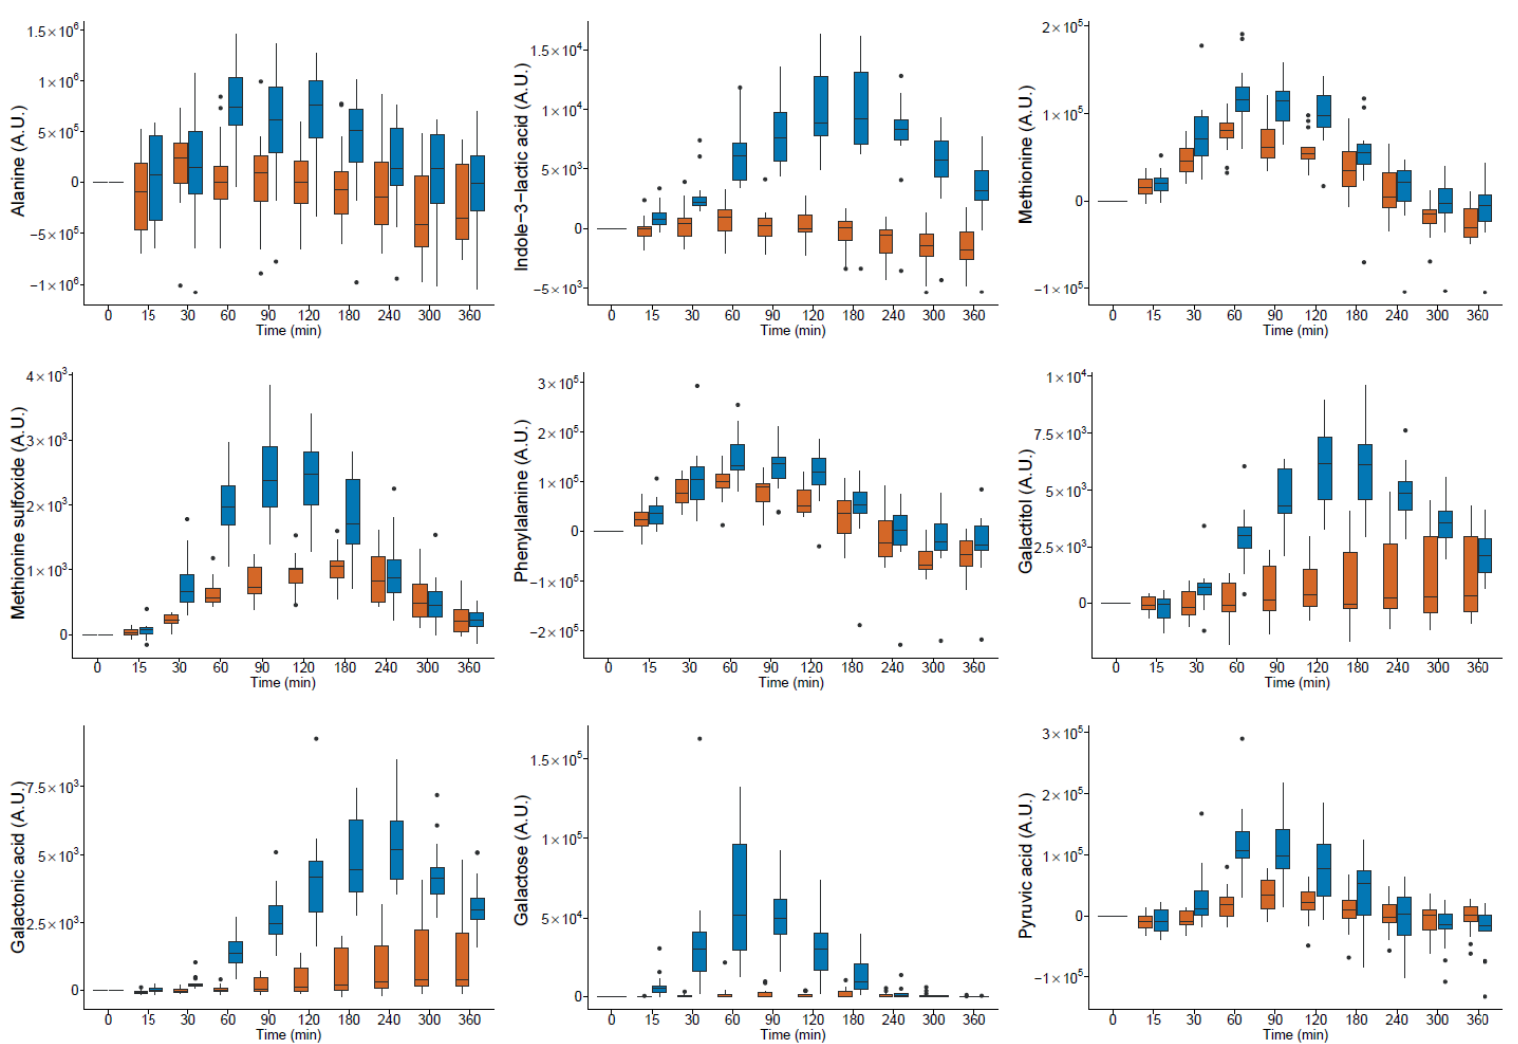
Figure 1. Kinetic of 18 postprandial active compounds in serum with a significant ( p < 0.05) difference in the iAUC after the intake of ∎ milk and ∎ yogurt; A.U. arbitrary units ( ● outlier).